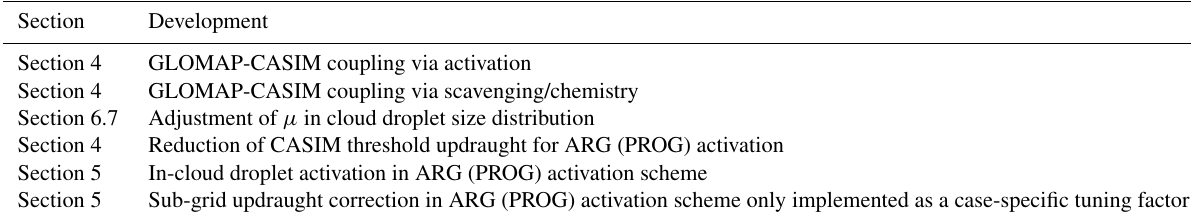
Table 6. Summary of model developments and adjustments documented in this